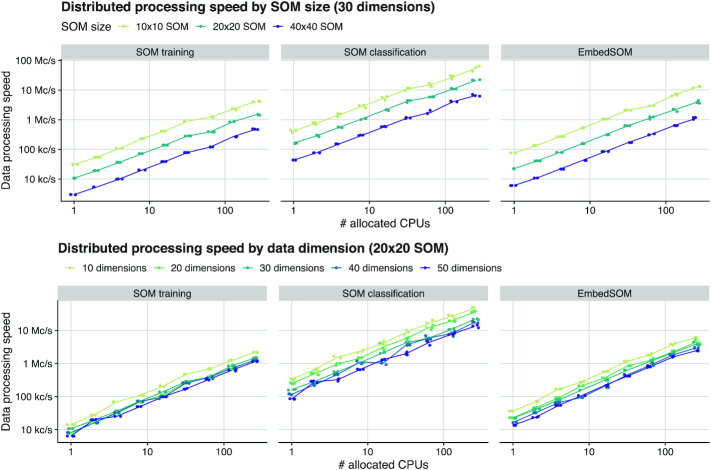
Performance dependency of distributed algorithms in GigaSOM on data dimensionality, SOM size, and number of available workers. Data processing performance is displayed as normalized to median speed in cells per second (c/s).